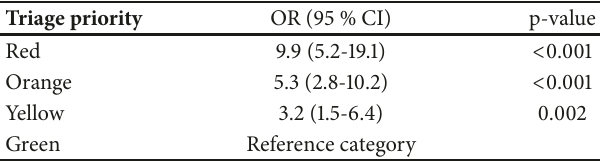
Table 4: Odds ratio for hospitalization according to triage priority.